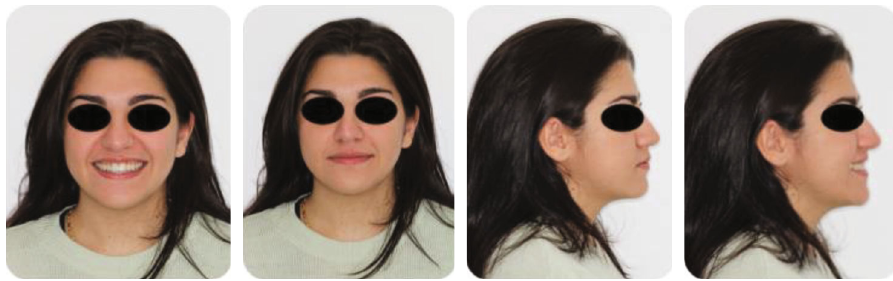
Figure 10: 12-month follow-up, extraoral